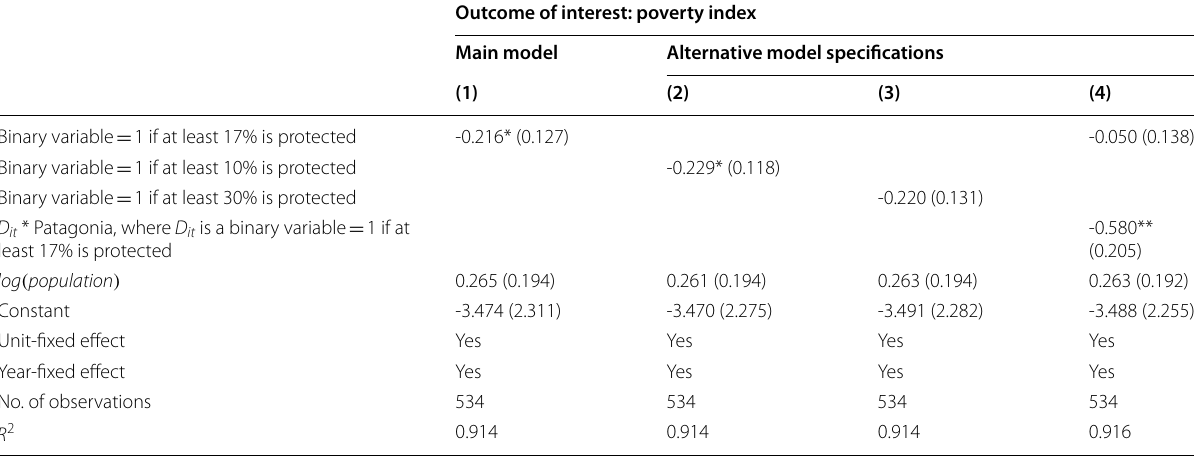
Robust standard errors clustered at the unit level are reported in parentheses. The levels of significance are *10%, and